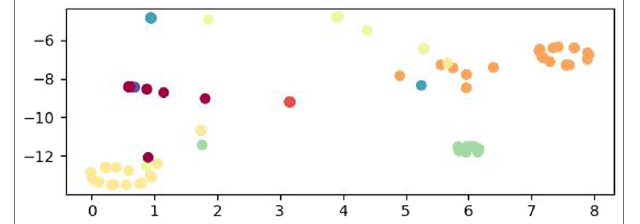
TABLE 6 | Comparison of different life prediction models.